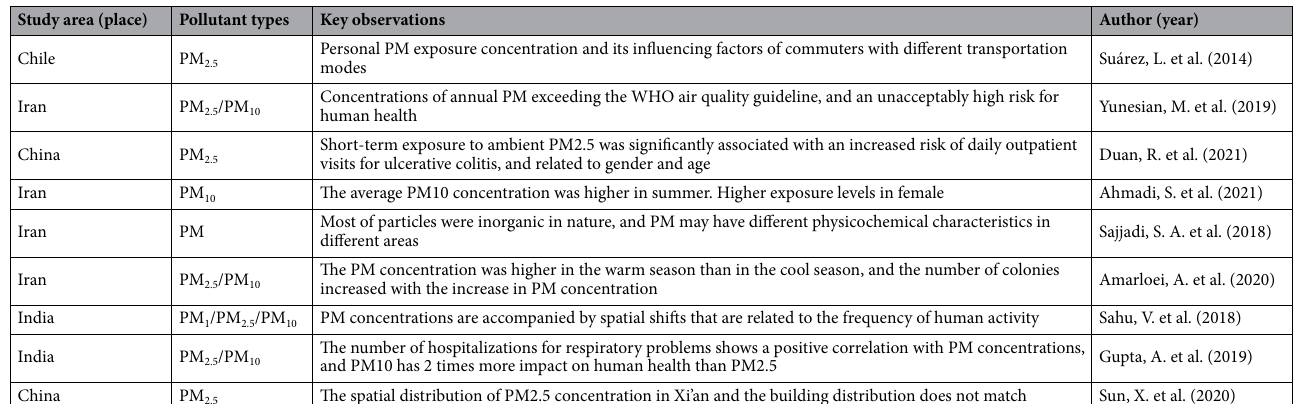
Table 1. Summary of relevant past the characteristics of PM concentration distribution and the relationship between PM concentration and health